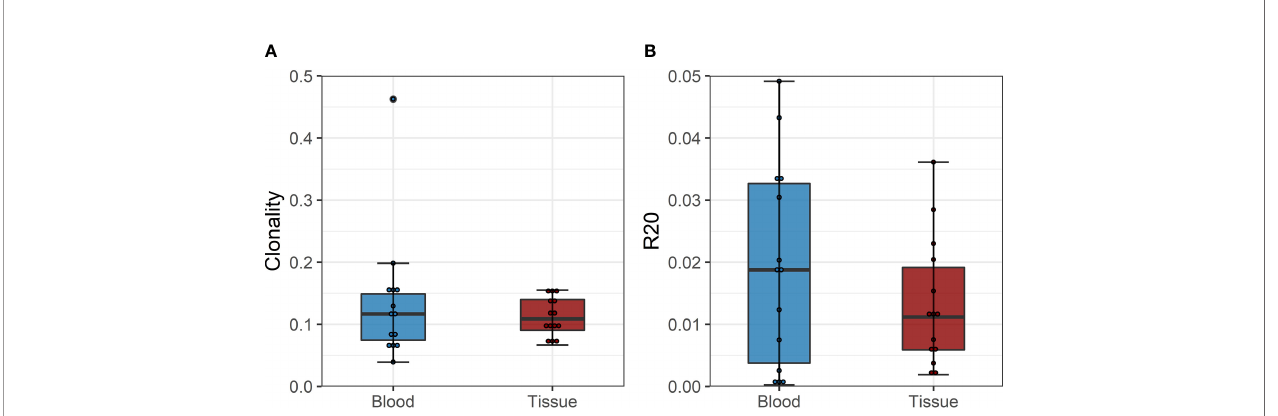
FIGURE 6 | (A) Boxplot of clonality estimates of the circulating and graft in fi ltrating TCR repertoire in patients with a cellular rejection episode at timepoint of rejection. (B) Boxplot of R20 estimates of the clonotypes of the circulating and graft-in fi ltrating TCR repertoire in patients with a cellular rejection episode at timepoint of rejection. No signi fi cant difference in diversity of the circulating and graft-in fi ltrating TCR repertoire is detected (clonality: p=0.411, mean dif.: -0.023, CI: -0.036, -0.082; R20: p=0.117, mean dif.: 0.006, CI: -0.002,